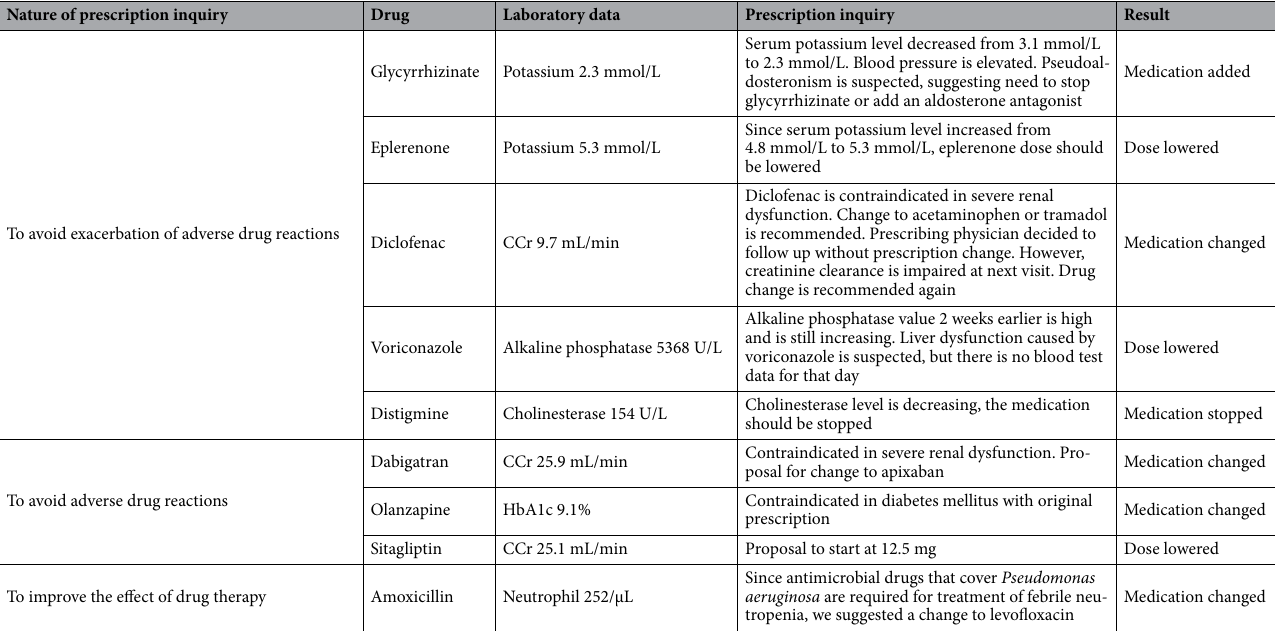
Table 2. Examples of prescription changes due to prescription inquiries related to laboratory